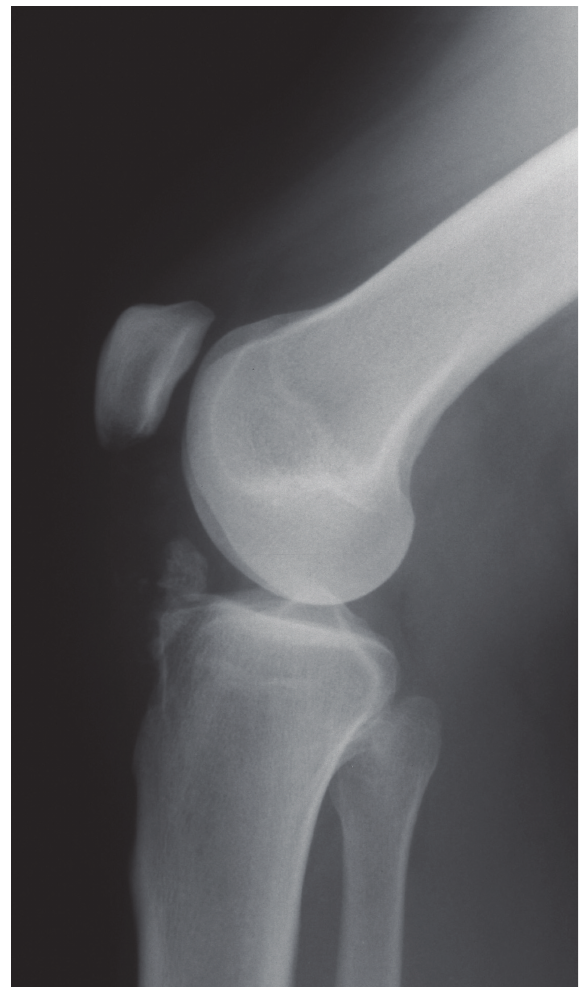
Figure 2: Osseous structure in the infrapatellar fat